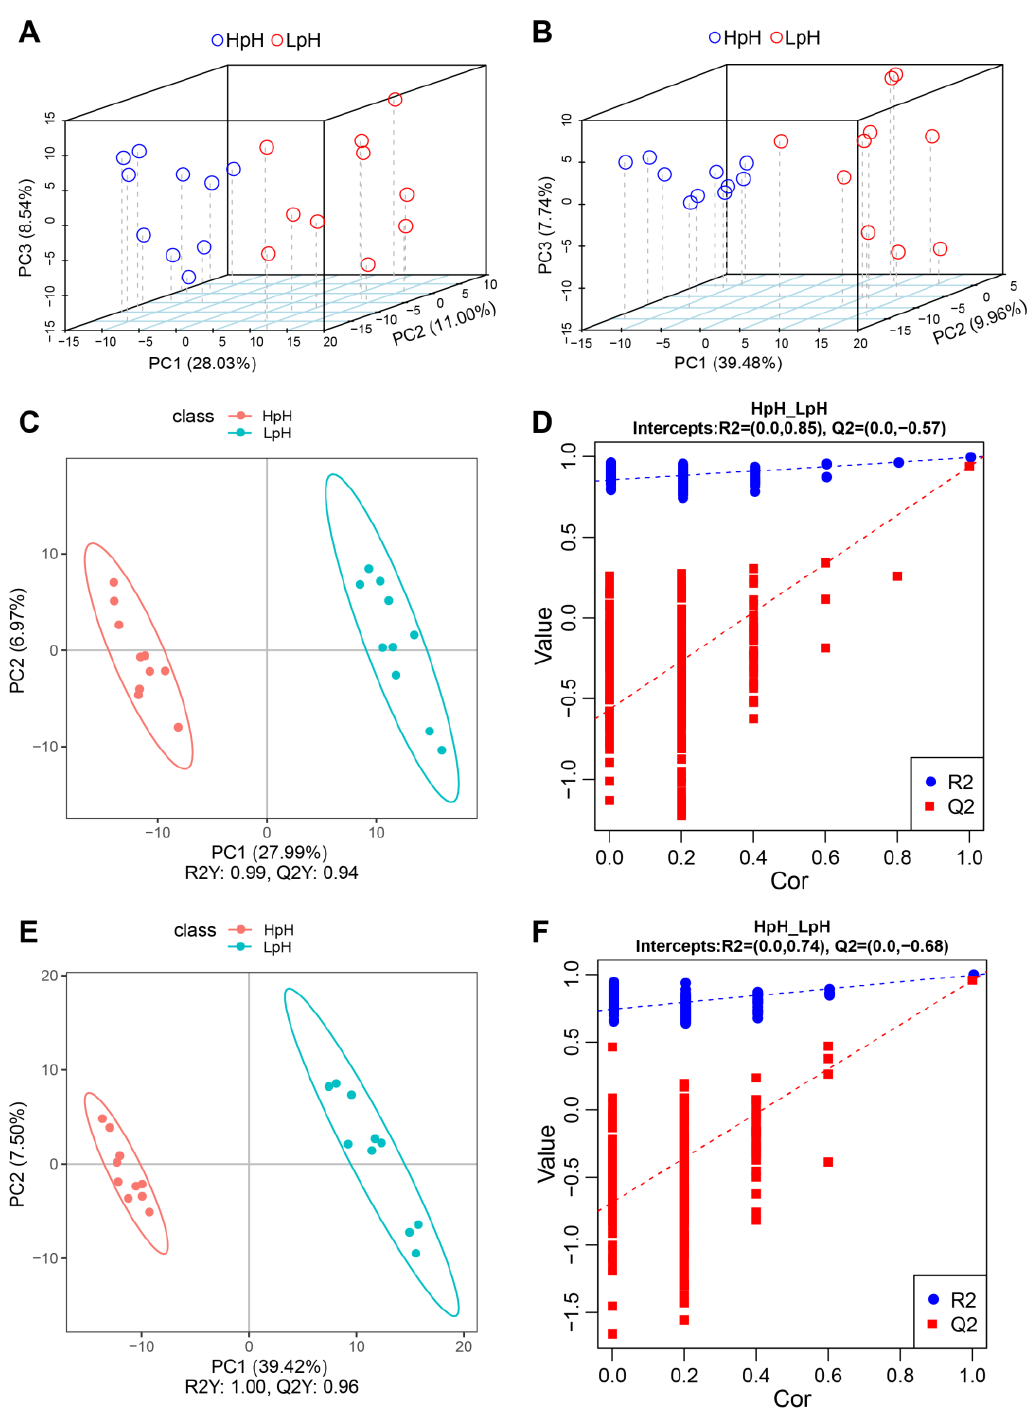
Figure 4. Three-dimensional score plots of principal component analysis (PCA) and partial least- squares discriminant analysis (PLS-DA) of metabolomic data in the plasma of porcine muscle with high pH (HpH) and low pH (LpH) in positive ( A ) and negative ( B ) modes. Score plot of PCA in positive ( C ) and negative ( E ) modes. Validation of the PLS-DA model using permutation tests in positive ( D ) and negative ( F )